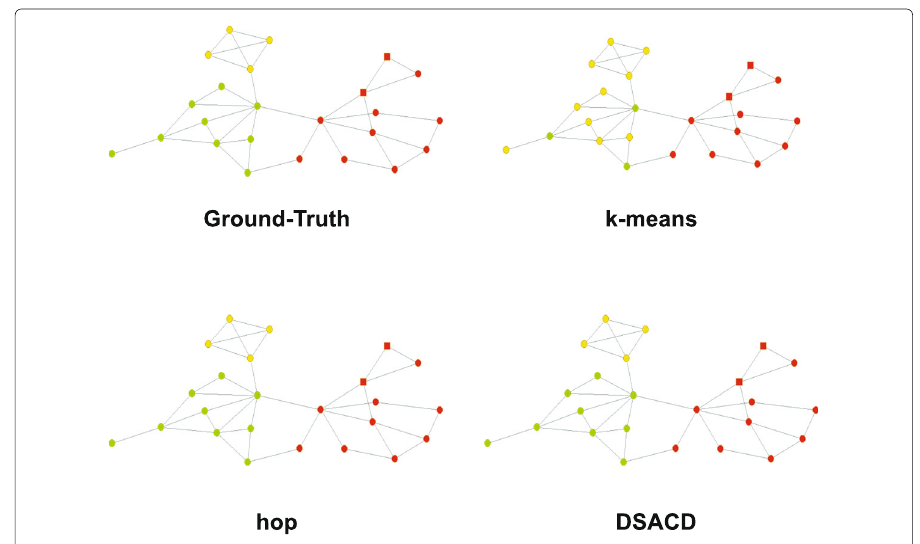
Fig. 9 Comparison of the actual results of the strike dataset and different cluster results